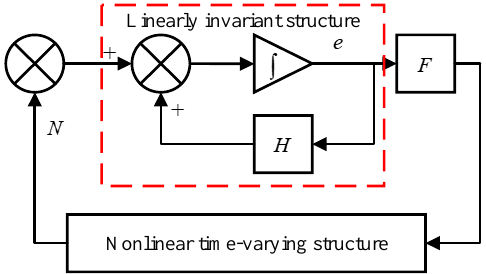
Figure 3. Block diagram of the adaptive rate system.